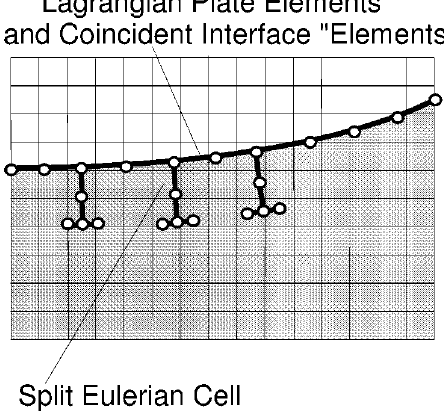
Fig. 7. A difficult coupling problem for CEL